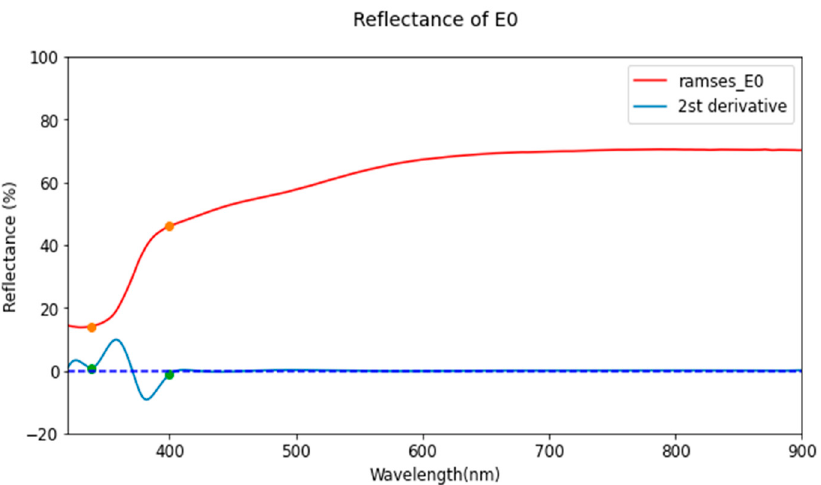
Figure 9. Hyperspectral reflectance spectra of a sample with a TiO 2 concentration of 15%, displayed with the second derivative of the spectra. Two inflection points are observed at around 338 nm and 400 nm where the second derivative equals to zero.